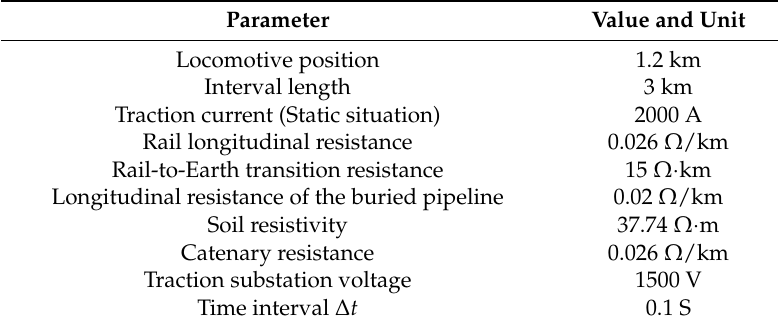
Figure 6. Surface potential gradient near the running rail under the bilateral power supply: ( a ) Along the locomotive running direction; ( b ) Vertical to the locomotive running direction.